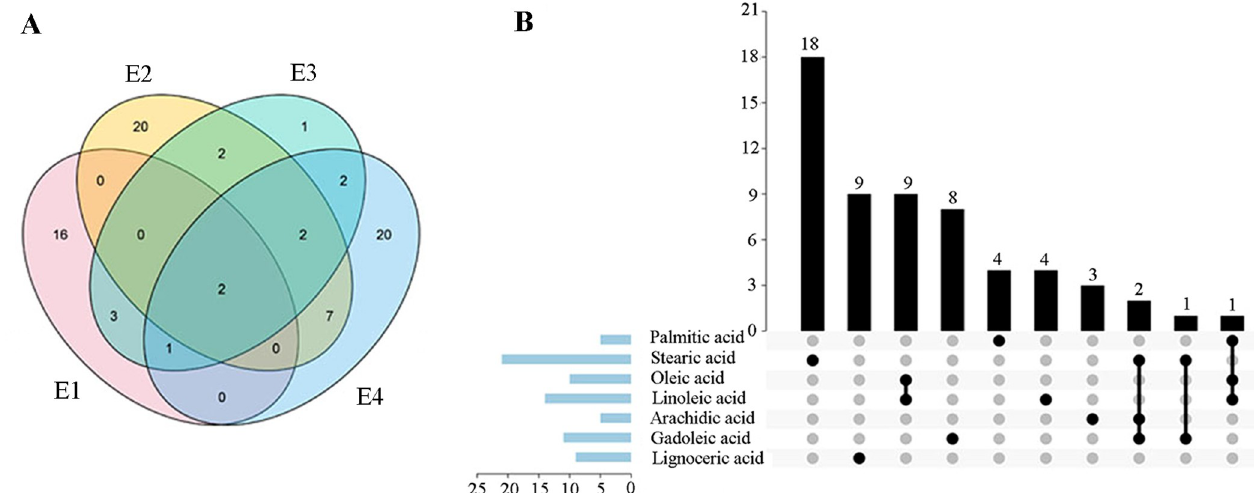
Fig 1. Overview of the significant associations identified for the fatty acid components ( P < 4.73 × 10 − 7 ). (A) Distribution and overlap of identified associated loci for fatty acid traits under “E1-E4” environments. (B) Profile of associations for individual traits or co-localized traits. The vertical column diagram shows the number of the associated loci for individual or multiple traits; the interactive plot shows that these traits identified same associated loci; the horizontal column diagram shows the number of associated loci for each trait. E1 refers to Nanchong in 2015; E2 refers to Wuhan in 2015; E3 refers to Nanchong in 2016; E4 refers to Wuhan in 2016.